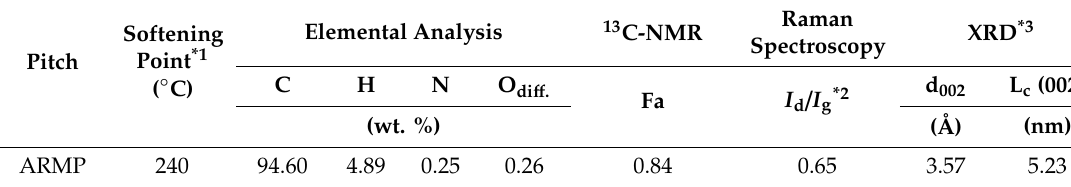
Figure A1. The schematic picture of the thermo-gravimetric analyzer (TGA) using a magnetic suspension balance for the oxidation–stabilization under atmospheric and pressurized conditions. Table A1. General properties of AR mesophase